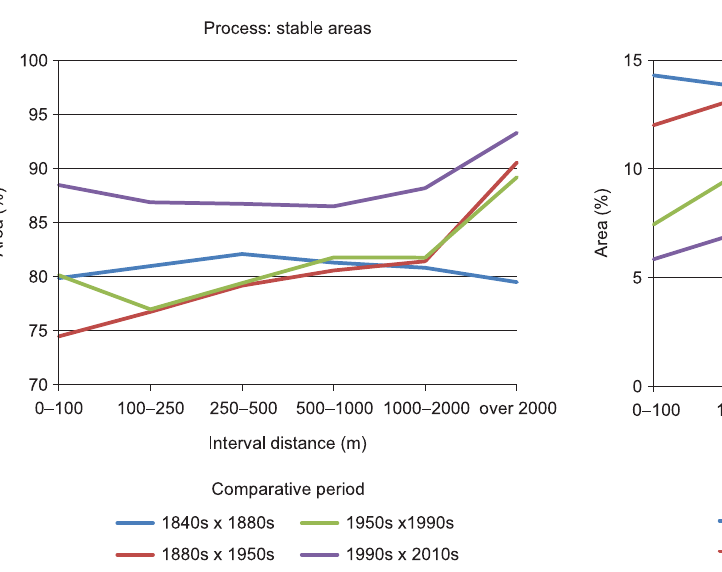
Fig. 8. The proportion (%) of stably used areas in the Hodonín region at various distances from existing roads.